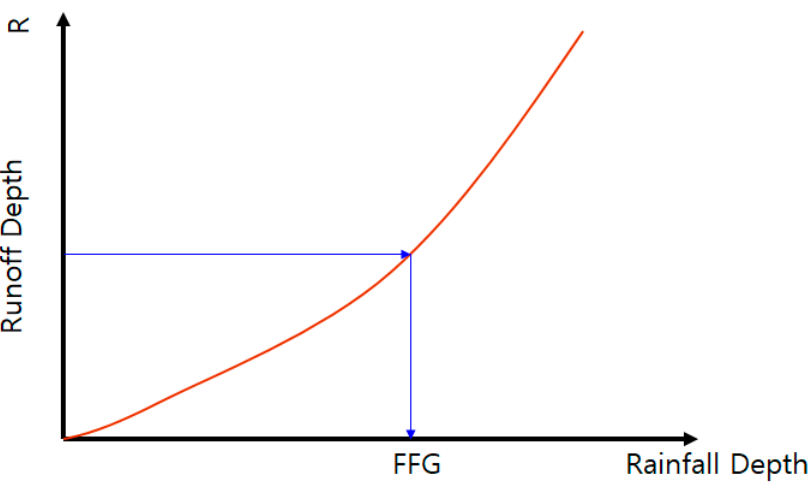
Figure 2. Concept of flash flood concept.